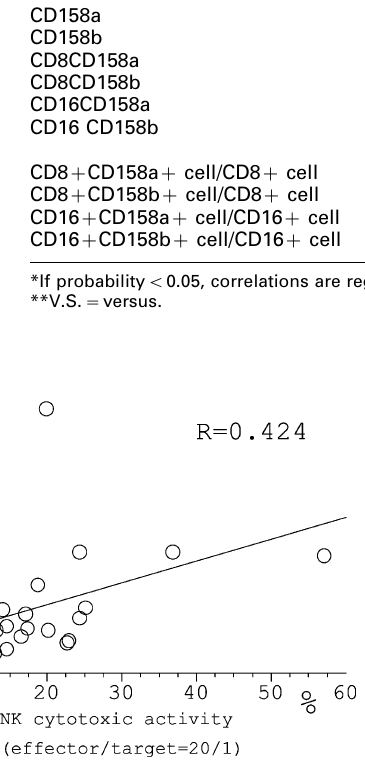
FIG. 1. The correlation of CD158a (cid:2) / cells with natural killing activity is shown. P (cid:4) / 0.0099, r (cid:4) / 0.424.